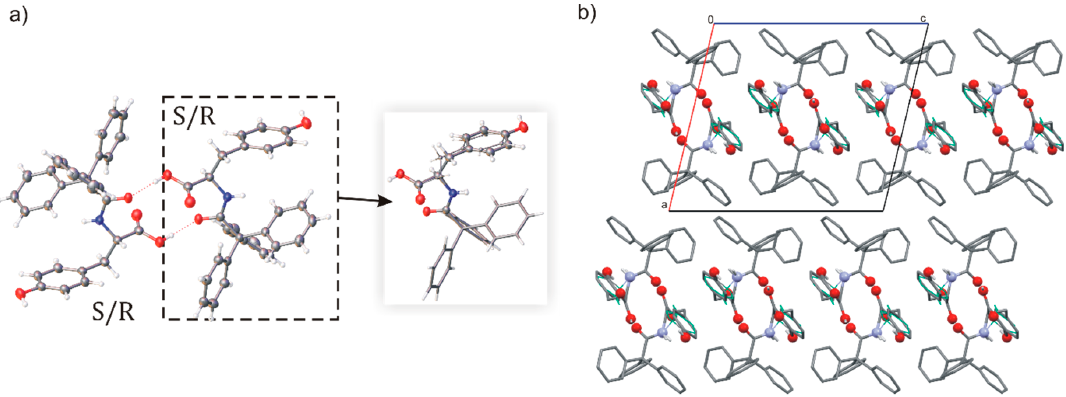
Figure 5. ( a ) Molecular structure of centrosymmetric dimmer in crystal of rac -TrCOTyr, hydrogen bonds are presented as dashed lines (compound crystallize as solid solution of enantiomers–model of disorder for the asymmetric molecule is shown in the frame, minor position indicated by thinner bonds) and ( b ) molecular packing in crystal structure.